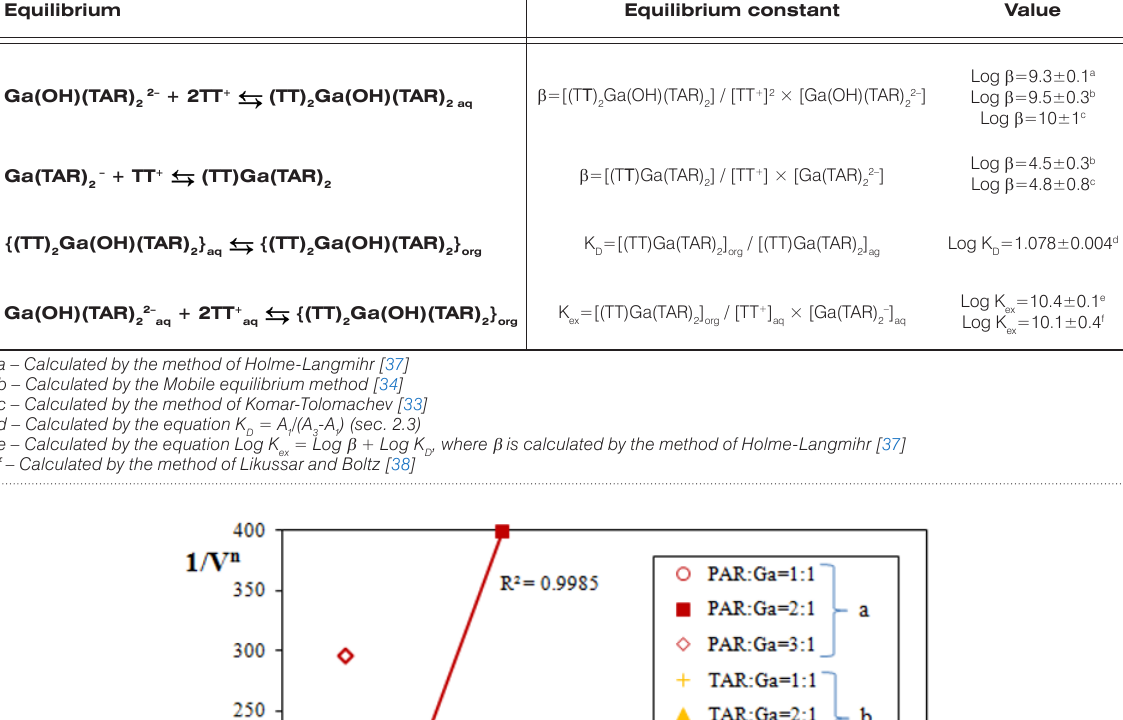
Table 4. Extraction equilibria and conditional equilibrium constants for the Ga(III)-TAR-TTC-water-chloroform system.